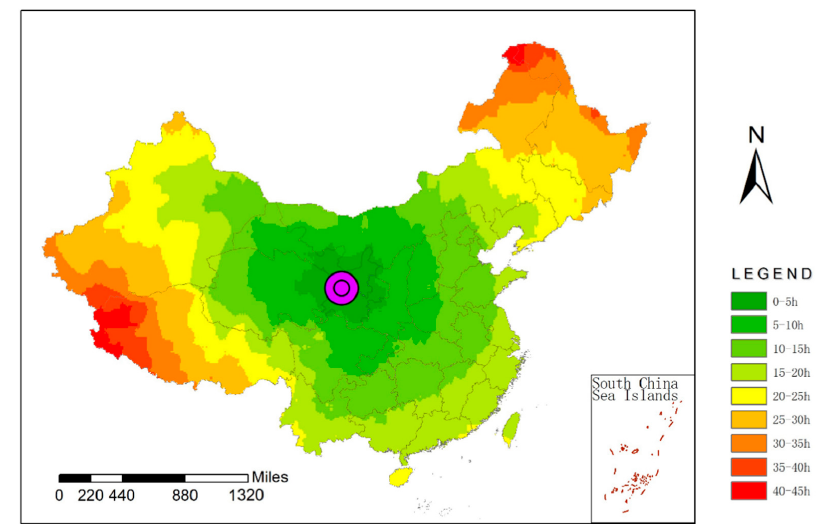
Figure 5. Isochronal circle map from Lanzhou to China.